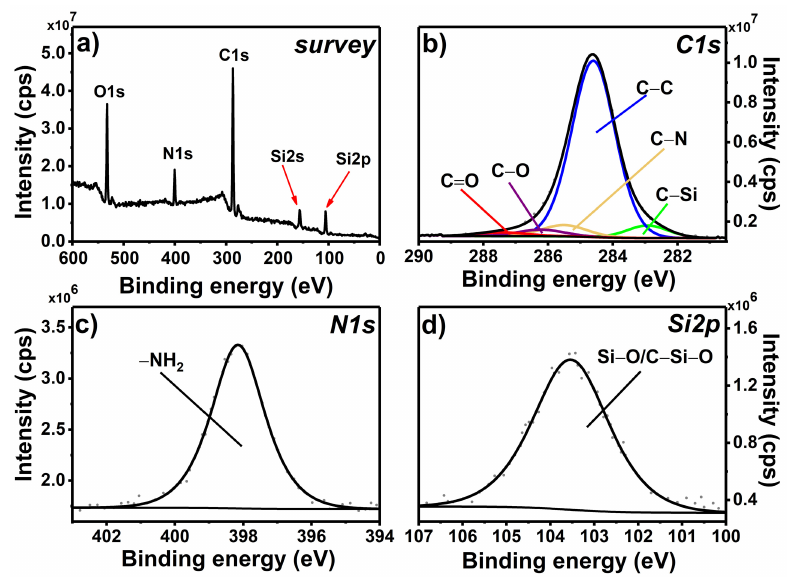
Figure 1. XPS survey spectrum ( a ) and high-resolution spectra of C1s ( b ), N1s ( c ), and Si2p ( d ) regions registered for the APTES@glass